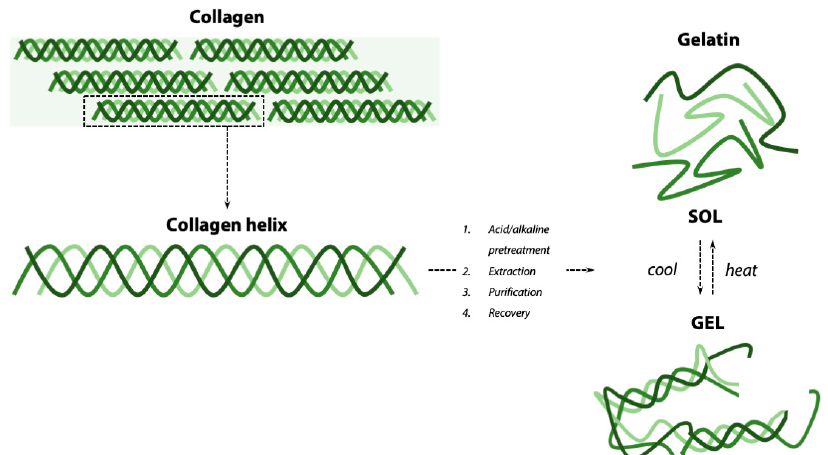
Figure 1. Processing of collagen for gelatin extraction. Collagen, characterized by a triple-helix structure and insolubility, is processed either by acid (gelatin A) or alkaline (gelatin B) pre-treatment. After extraction, purification, and recovery, gelatin, a soluble product, is obtained. When dissolved in water, gelatin undergoes a reversible sol-gel transition by heat–cool process.